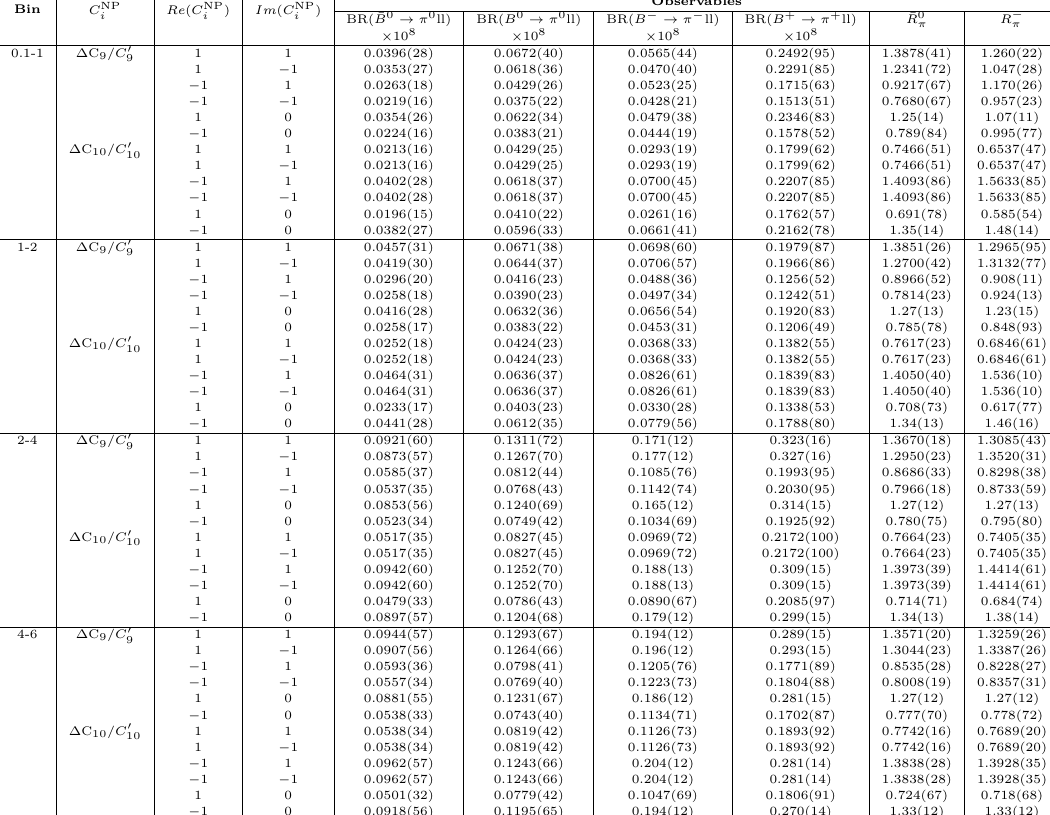
for 9 , 10 denotes the charge of the initial π